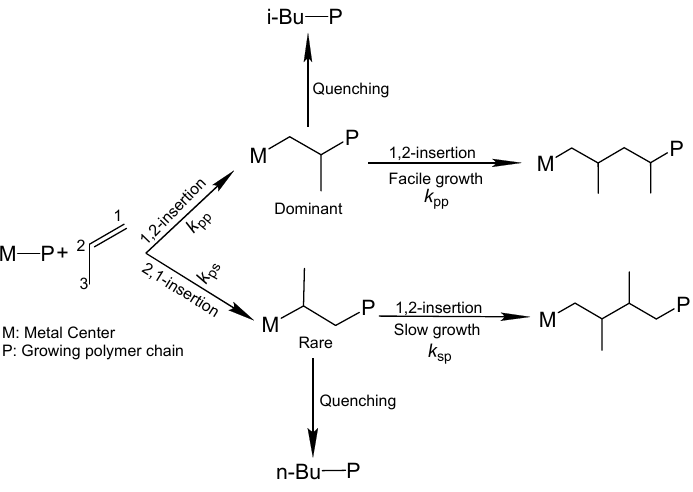
14 Figure 11. ( a ) Yield development in LSF propylene polymerization using a co-ground catalyst (TiCl 4 /1,3-diether/MgCl 2 ): ( Δ ) New quenching and ( □ ) conventional quenching; ( b ) Scalability test with the new quenching method. The tube length was fixed at 2 s, while the cumulated flow volume was increased [38]. 5. Regiochemistry of Ziegler–Natta Propylene Polymerization The isoselective polymerization of propylene by heterogeneous ZN catalysts involves multiple cis-insertions of the prochiral monomer with the same enantioface, in which the stereoselection mechanism is mainly determined by the asymmetric nature of the active sites [51].